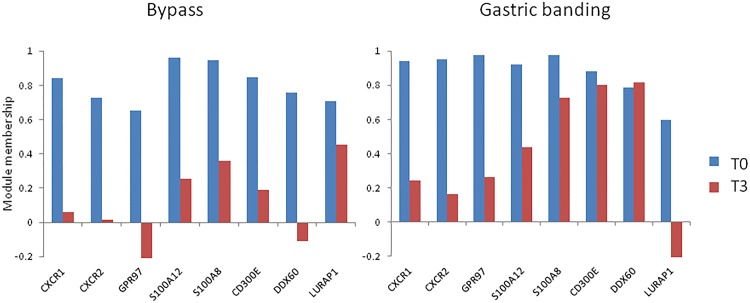
Module membership of some genes of interest before (T0) and after surgery (T3), separately in RYGB and AGB.The module membership of a gene represents the correlation to its module eigengene. For each module, the eigengene at T3 was calculated on the same gene set as at T0.